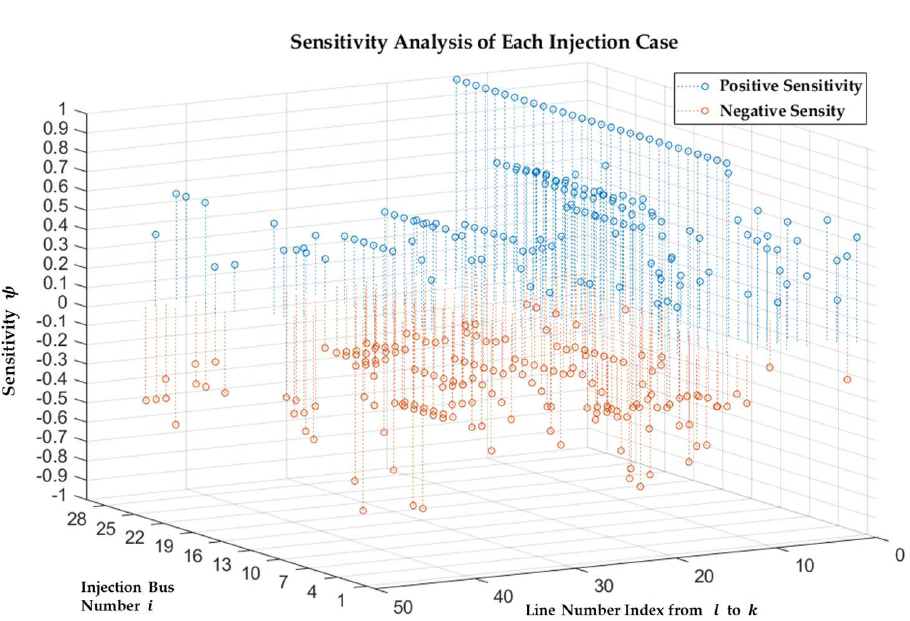
Figure 2. Sensitivity analysis result of test system.